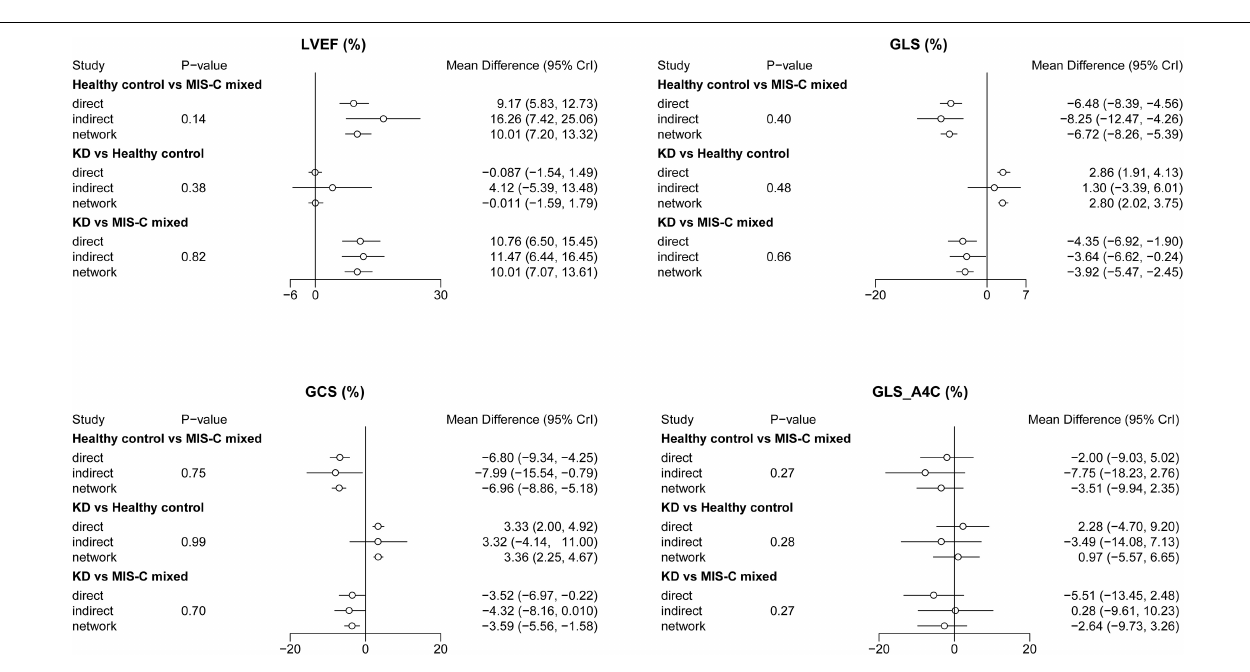
FIGURE 3 | Forest plots of network meta-analysis of all studies. GCS, global circumferential strain; GLS, global longitudinal strain; GLS_A2C, global longitudinal strain_apical two-chamber; GLS_A3C, global longitudinal strain_apical three-chamber; GLS_A4C, global longitudinal strain_apical four-chamber; KD, Kawasaki disease; LVEF, left ventricular ejection fraction; MIS-C, multisystem inflammatory syndrome in children; MIS-C dEF, Multisystem Inflammatory Syndrome in Children with depressed ejection fraction; MIS-C pEF, Multisystem Inflammatory Syndrome in Children with preserved ejection fraction.